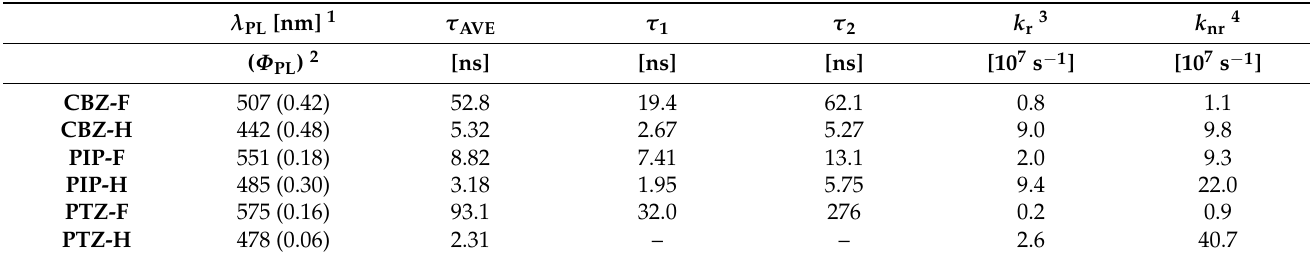
Figure 5 Figure 5. PL spectra of ( a ) CBZ-F and CBZ-H , ( b ) PIP-F and PIP-H , and ( c ) PTZ-F and PTZ-H in crystalline states. Excitation wavelength ( λ ex ): 300 nm ( CBZ-F , CBZ-H , PIP-H , PTZ-F ), 310 nm ( PIP-F , PTZ-H ). ( d ) CIE color diagram of all derivatives. Table 3. Photophysical data of D- π -A-type tolane with an amine-based donor in